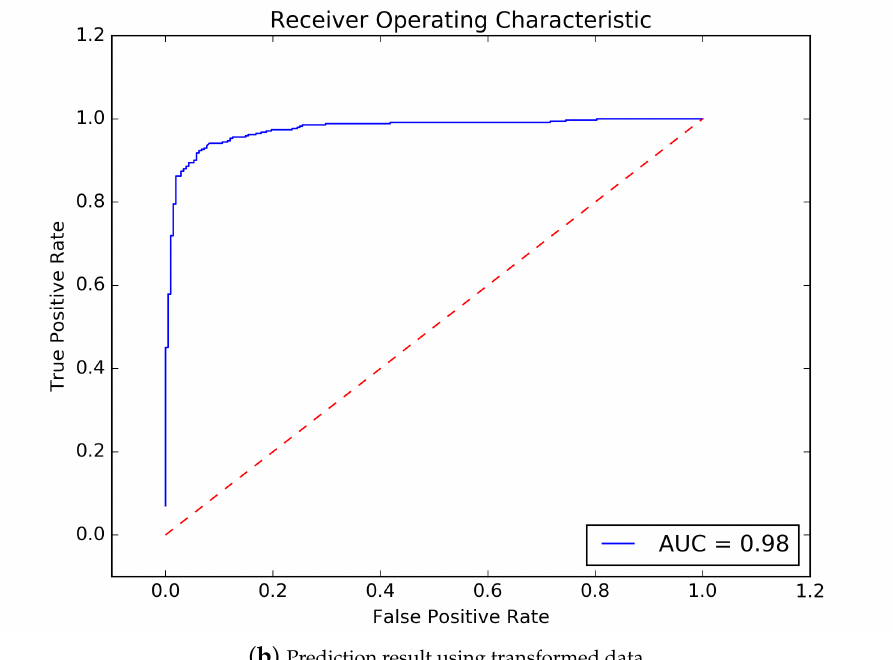
Figure 5. Influence of data transformation on results.